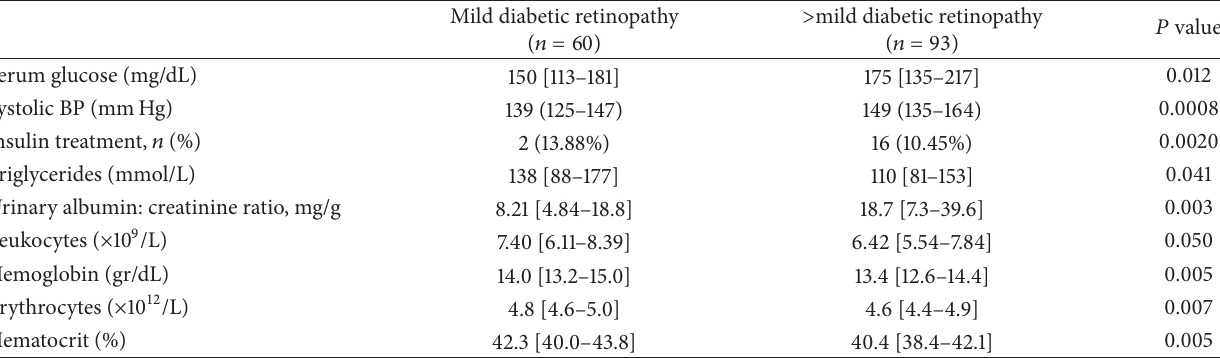
Table 2: General and hematological variables that showed statistically significant differences in the comparison between groups according to severity of retinopathy in the group of patients with diabetic retinopathy. ( 𝑛 = 60